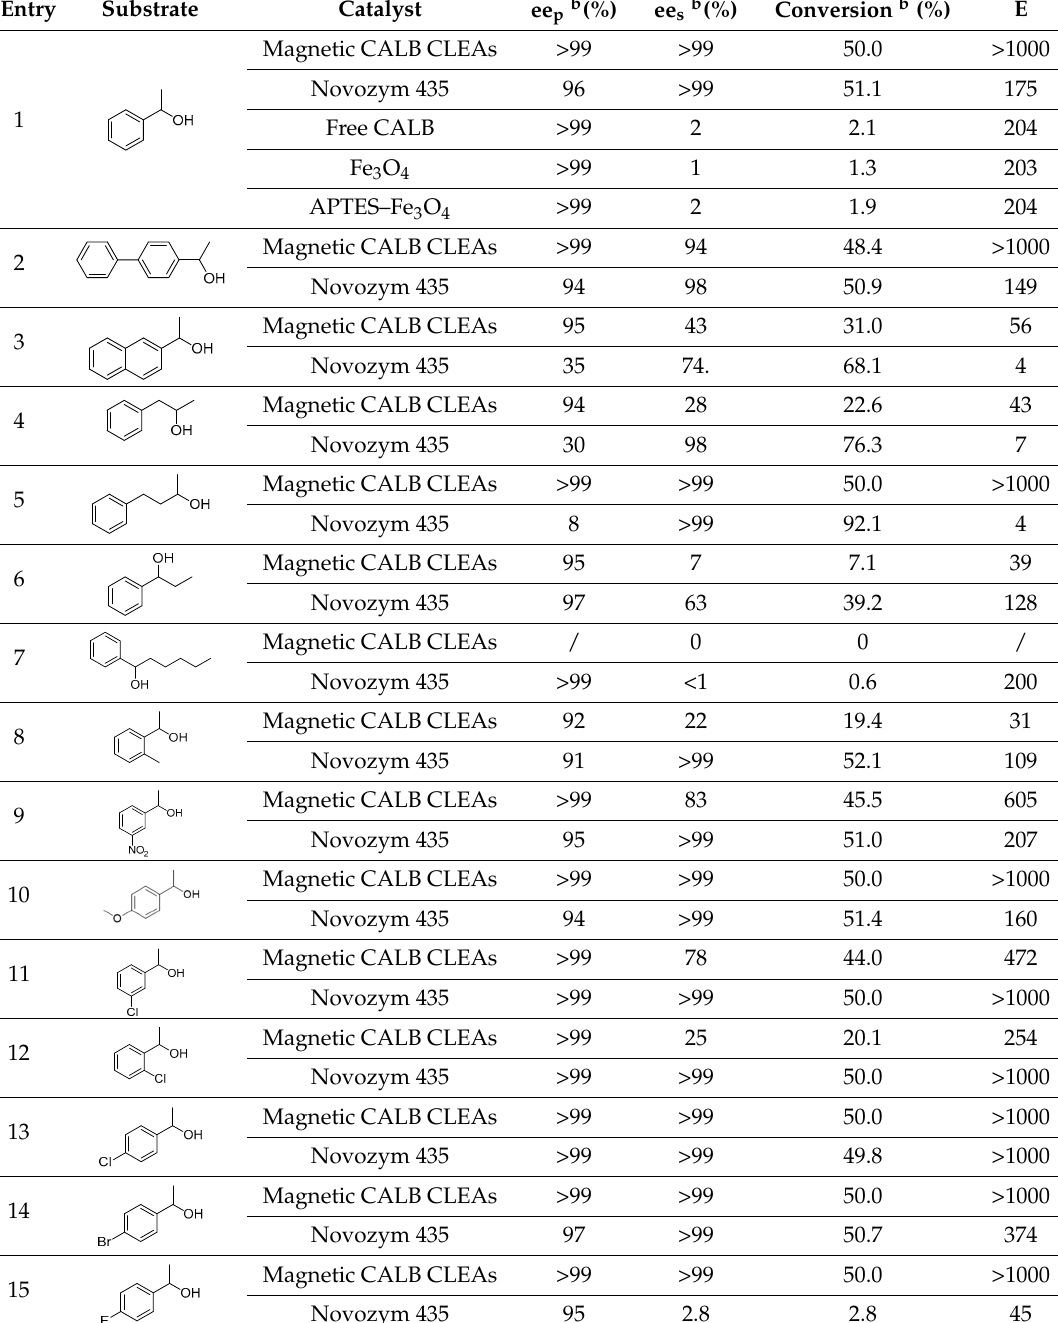
Table 2. Comparison of resolution of secondary alcohols between Magnetic CALB CLEAs and Novozym 435 a